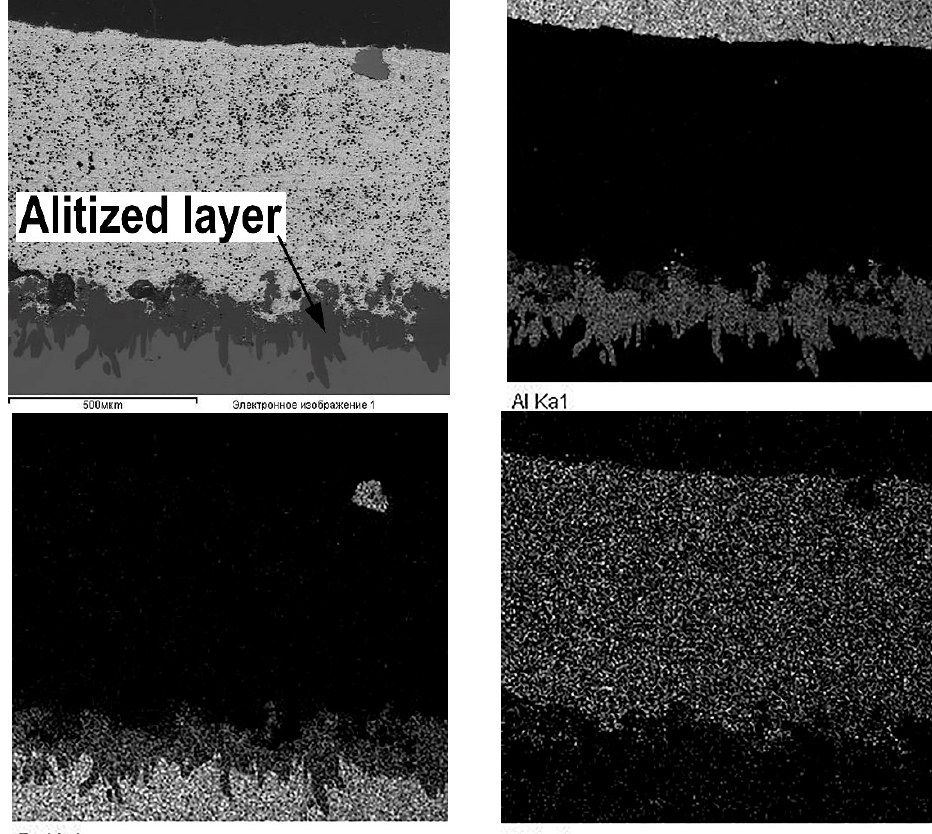
Figure 6. The alitized layer at the boundary of the lead sublayer and the steel base.